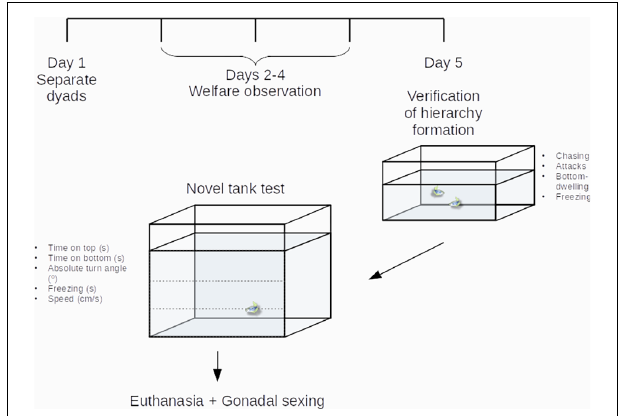
FIGURE 1 | Experimental design. Zebrafish dyads were established on Day 1, had welfare endpoints checked during Days 2–4, after which hierarchy formation was verified on Day 5. After behavioral observations of aggressive and territorial behavior, animals were transferred and observed individually in the novel tank test. See the “Methods” section for more